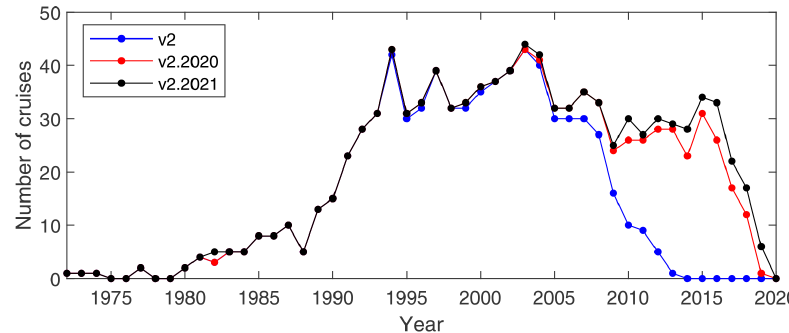
Figure 2. Number of cruises per year in GLODAPv2, GLODAPv2.2020, and